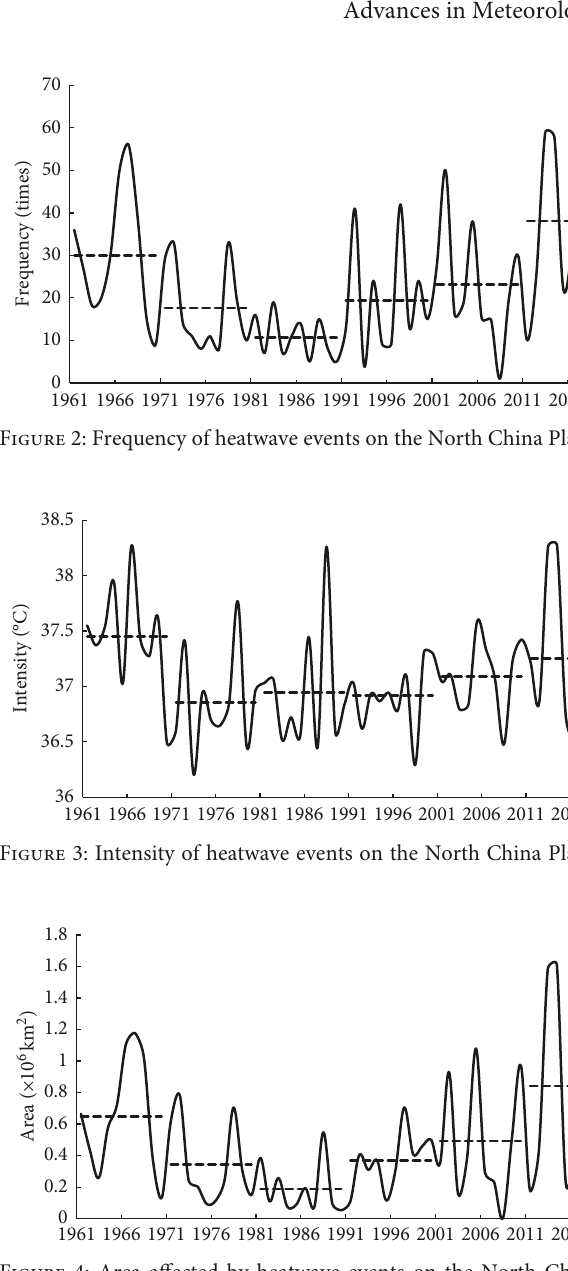
Figure 4: Area affected by heatwave events on the North China